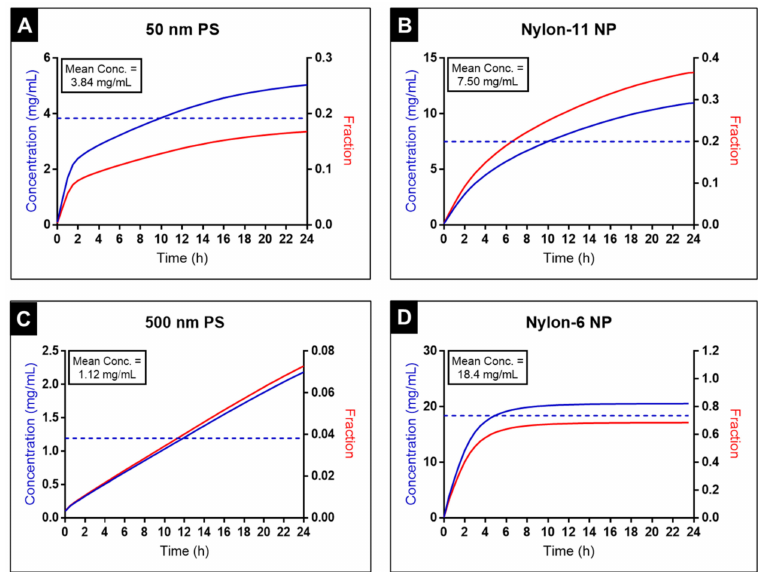
Figure 4. Effective dosimetry concentration (blue line) and fraction (red line) calculated for each of the four particles at the bottom of the well proximal to the RAW 264.7 cells using the ISDD model. The mean particle concentration throughout the 24 h exposure is indicated with a blue dotted line for each particle type, and the calculated mean concentration is listed in the box on each graph ( A – D